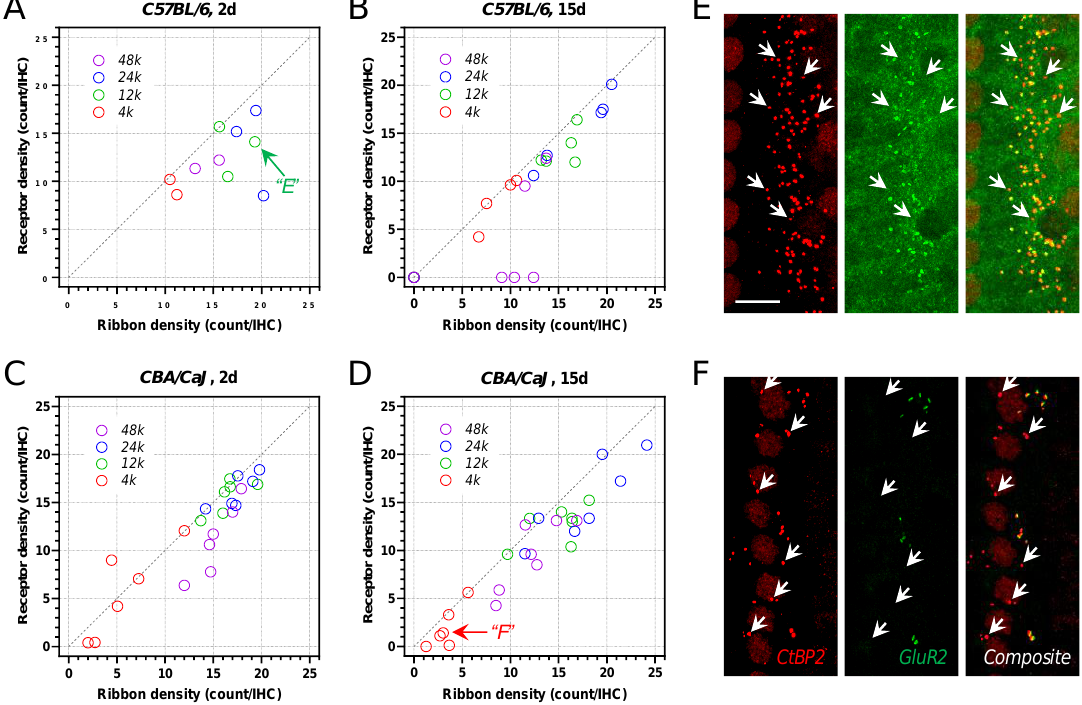
Figure 7. Correlation between presynaptic ribbon density and post-synaptic AMPA receptor den- sity. ( A ) 2 days after 400 G/200 F treatment in B6 mice. ( B ) 15-day posttreatment in B6 mice. ( C ) 2- day posttreatment in CBA mice. ( D ) 15-day posttreatment in CBA mice. ( E ) Presynaptic ribbons (red) and post-synaptic AMPA receptors (green) at the 12-kHz location from a B6 mouse 2-day posttreat- ment. Arrows indicate orphan ribbons. Scale bar = 10 µm. ( F ) Ribbons and receptors at the 4-Hz location from a CBA mouse 15-day posttreatment.